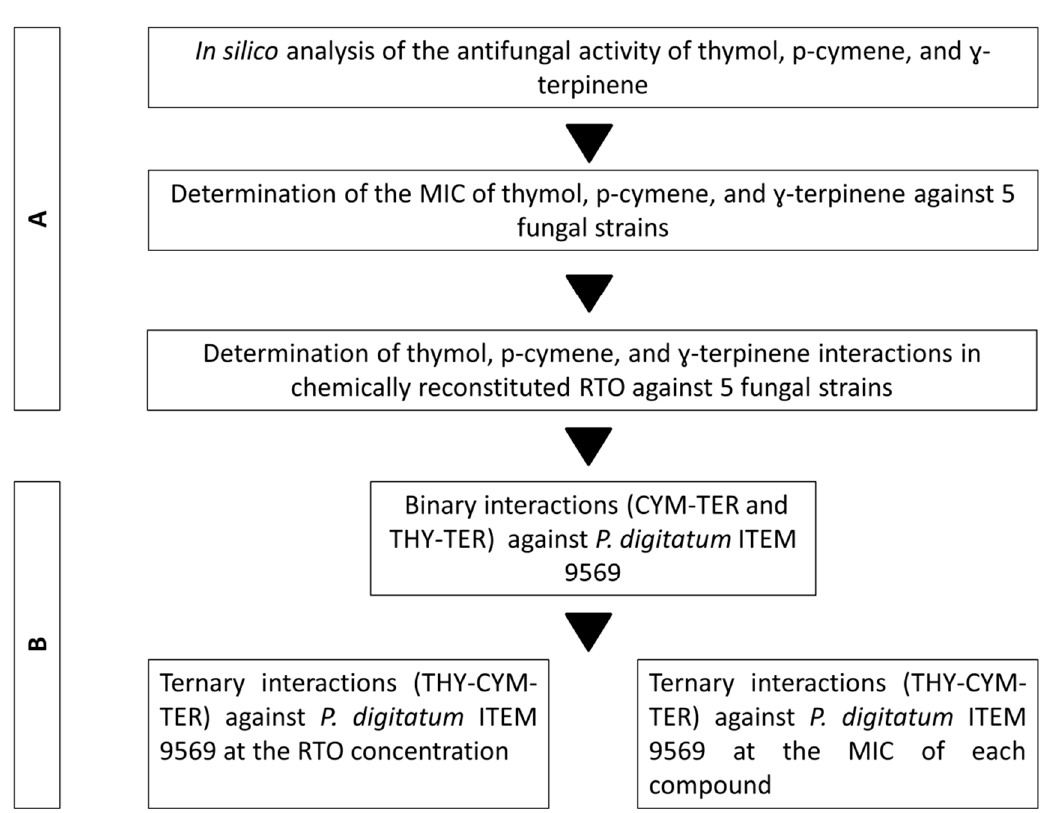
Figure 1. Workflow of the experimental activity. Evaluation of the antifungal e ff ect of single red thyme essential oil compounds (RTOCs) ( A ) and evaluation of their potential additive / synergistic e ff ect against the RTO-resistant P. digitatum ITEM 9569 ( B ). Abbreviations: THY, thymol; CYM, p-cymene; TER, γ -terpinene.